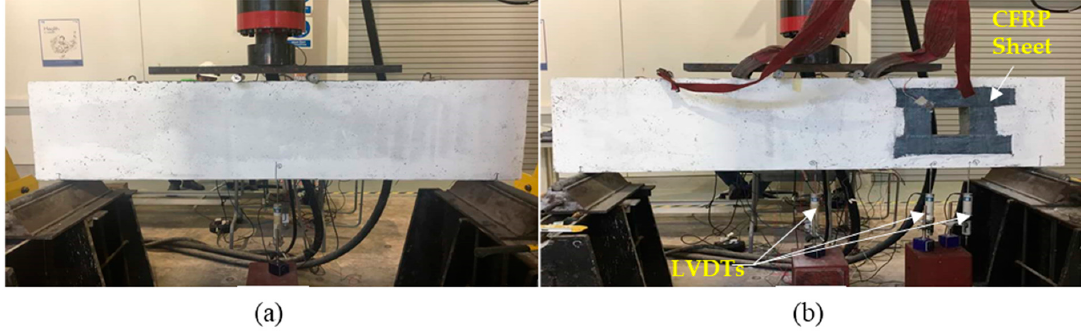
Figure 4. Equipment and testing setup: ( a ) control beam; and ( b ) deep beam with opening.